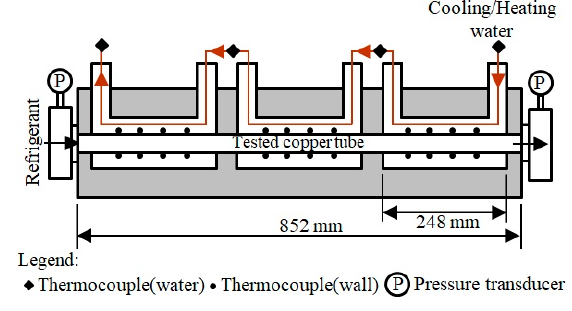
Figure 2. Details of the test section.